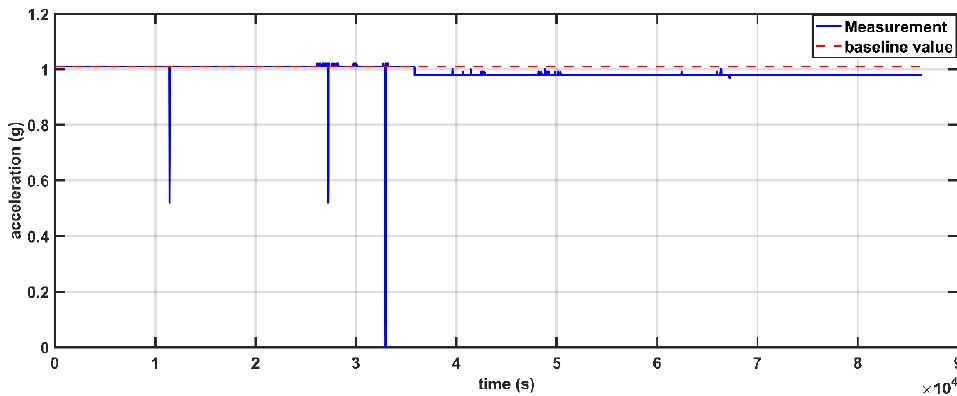
Figure 8. Baseline acceleration